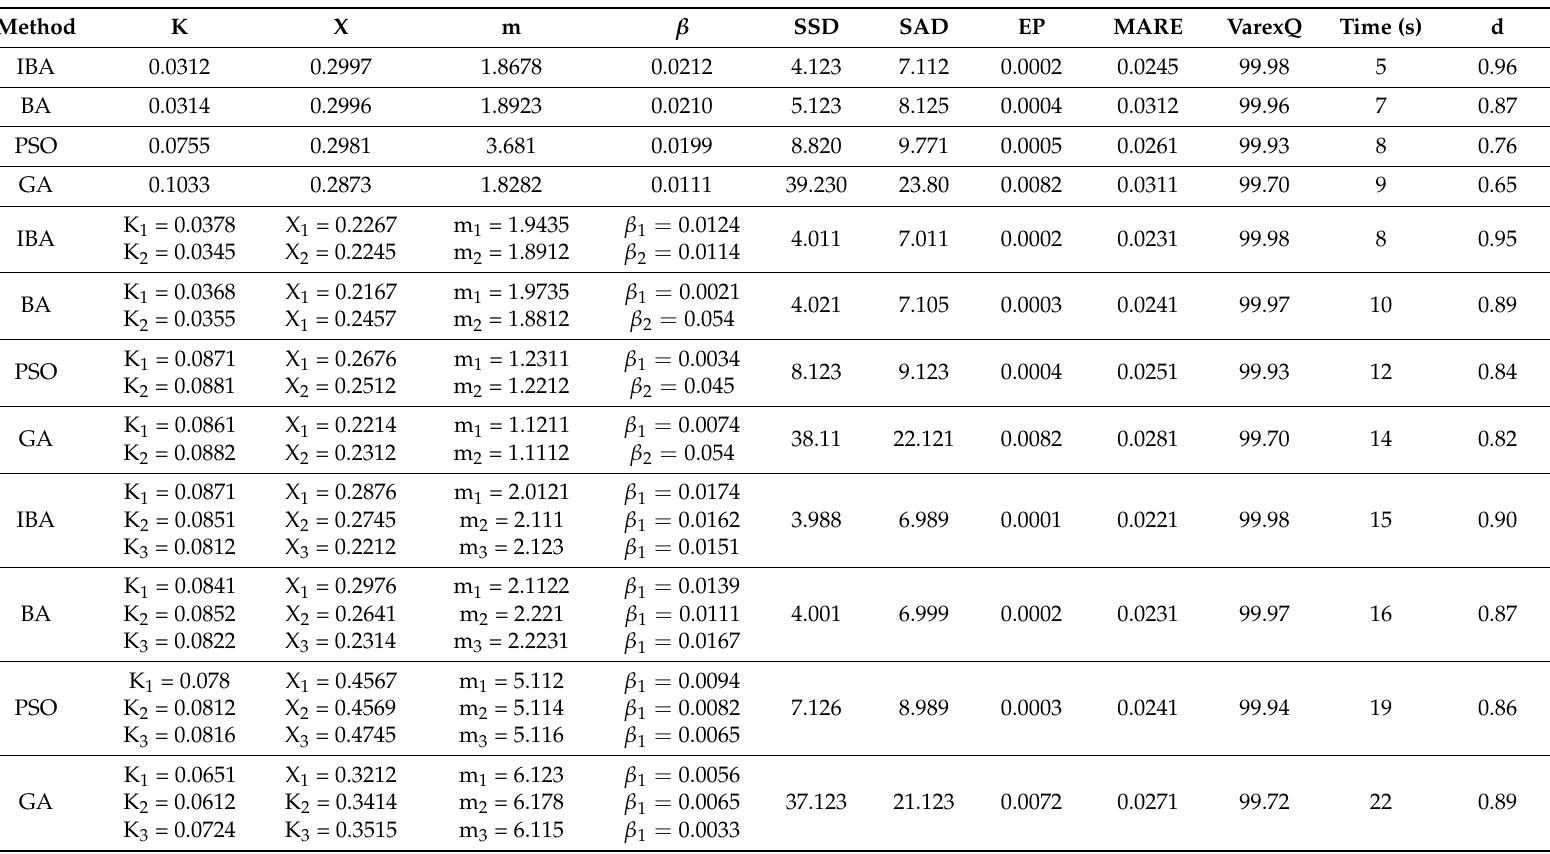
Table 5. Flood routing for Wilson flood according to three different